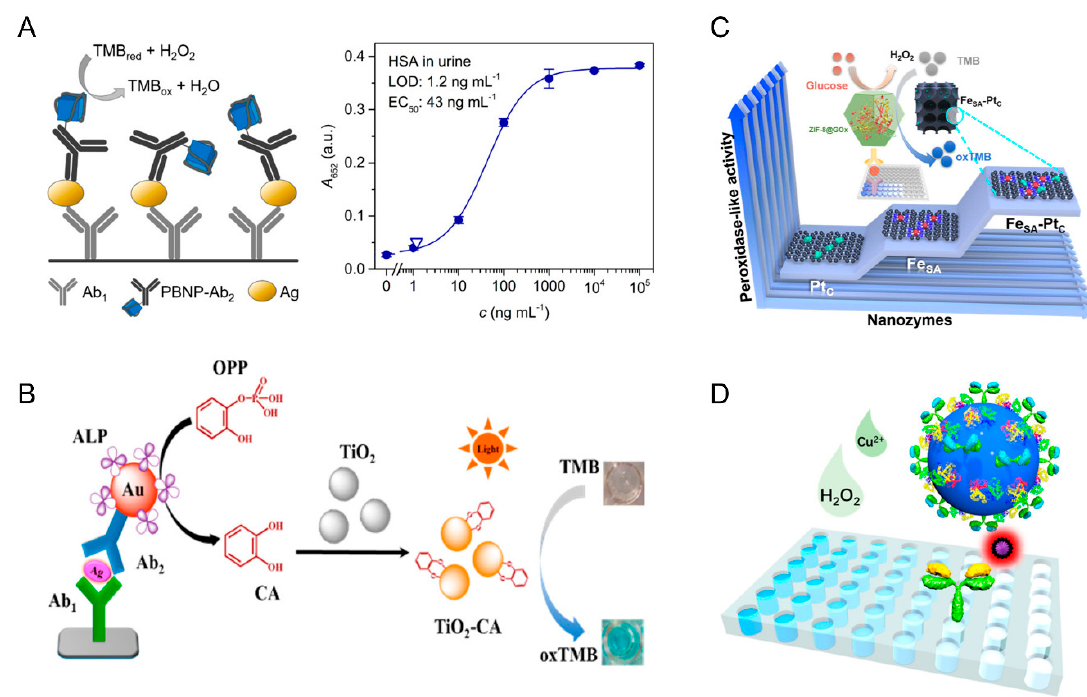
Figure 1. ( A ) Schematic diagram of PBNP-based sandwich NLISA [26]. Reprinted with permission from ref [26]. Copyright 2018 American Chemical Society. ( B ) Scheme of mechanism of catalytic oxidation of TMB by photo-activated TiO 2 − CA for the quantitation of ALP [30]. Reprinted with permission from ref [30]. Copyright 2015 American Chemical Society. ( C ) Scheme of the cascade reaction for the detection of PSA by FeSA − PtC nanozymes based ELISA [35]. Reprinted with permission from ref [35]. Copyright 2021 American Chemical Society. ( D ) Scheme of sandwich-type TLISA for the detection of IL-6 by using TMB NPs [37]. Reprinted with permission from ref [37]. Copyright 2019 American Chemical Society.